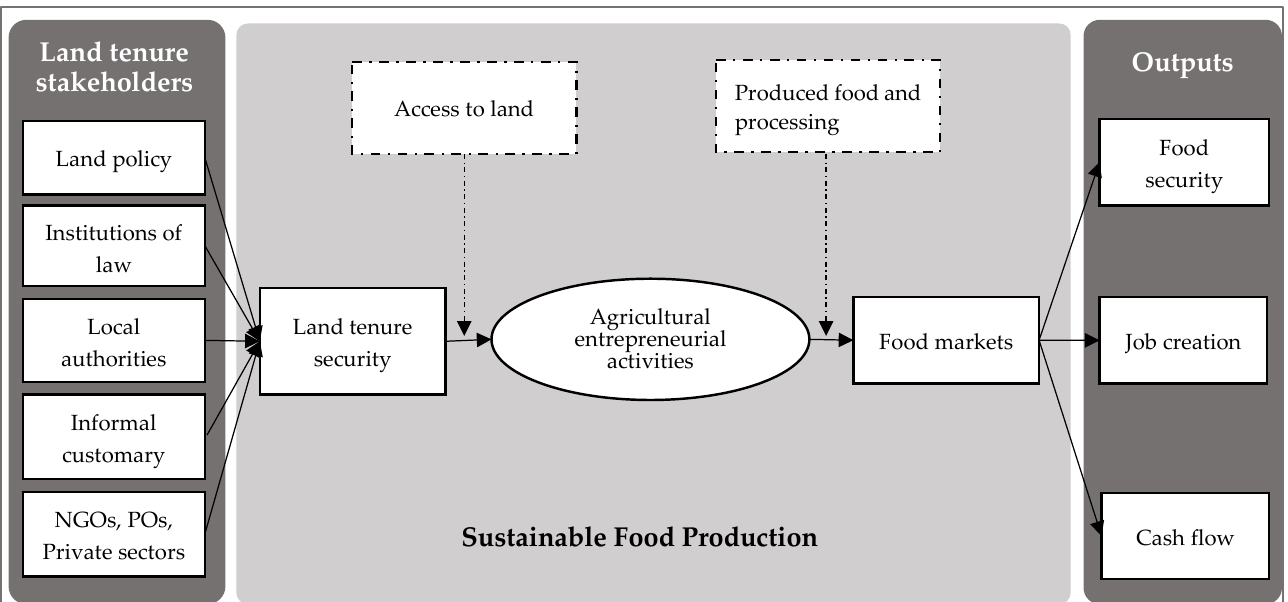
Figure 2. Conceptual framework.